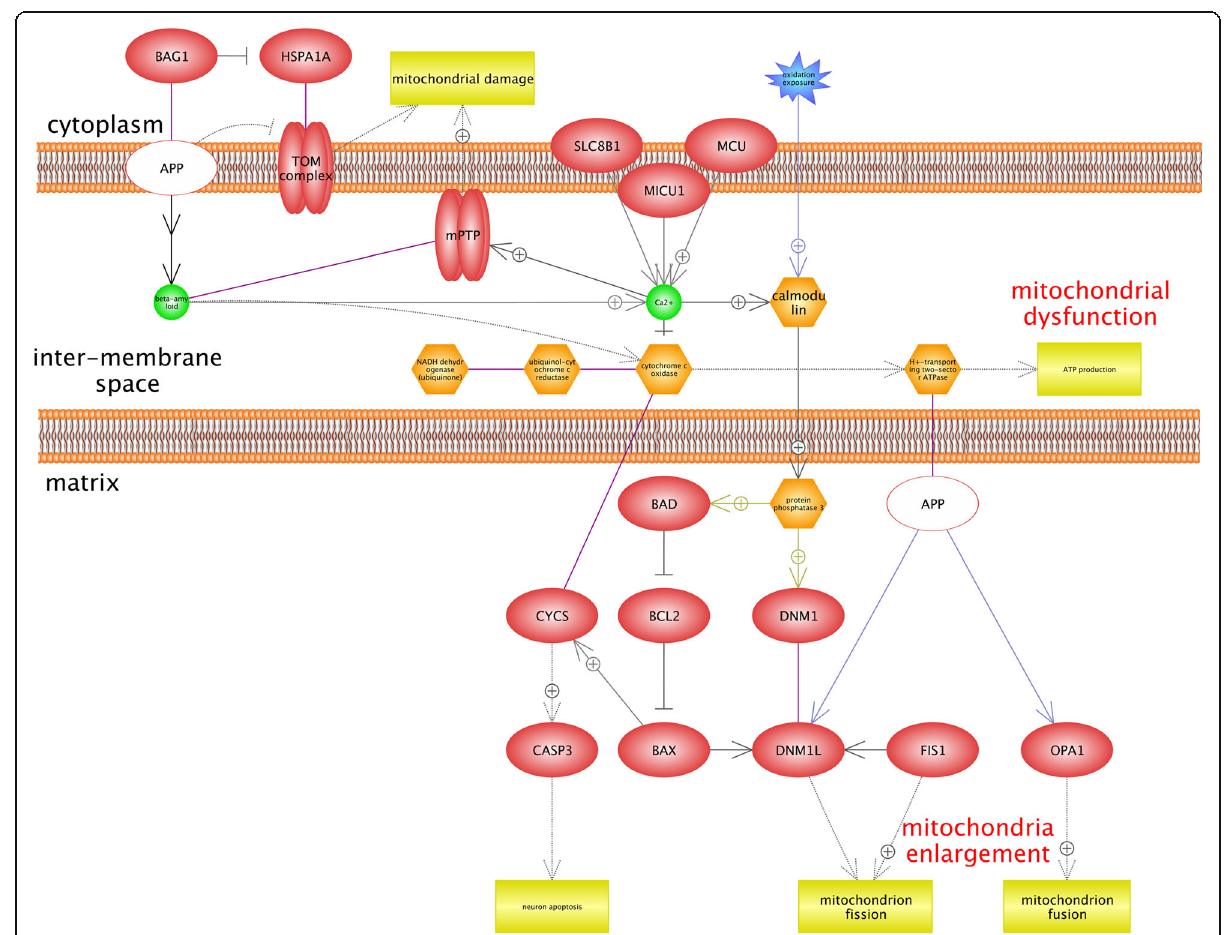
Fig. 4 Gene network analysis to identify the roles of hypoxia-associated genes in Alzheimer ’ s disease (AD). This figure shows two main protein complexes including TOM (translocase of the outer mitochondrial membrane) and MPTP (mitochondrial permeability transition pore) that play a critical role in AD. Most of the proteins of mitochondrion are produced in the cytoplasm, and then, they are imported to the mitochondrion by the TOM complex. However, APP (amyloid precursor protein) inhibits the TOM complex and leads to the mitochondrial damage. The accumulation of β -amyloid peptide (A β ) is recognized as one of the main features of AD. Mitochondrial calcium is overloaded by A β and MCU (mitochondrial calcium uniporter). Based on our results, there is an association between mitochondrial calcium overloads that induces the activity of MPTP, which is related to mitochondrial dysfunction because it is opened in the inner mitochondrial membrane. It is recognized that protons can cross into the mitochondria and lead to the ATP depletion and mitochondria